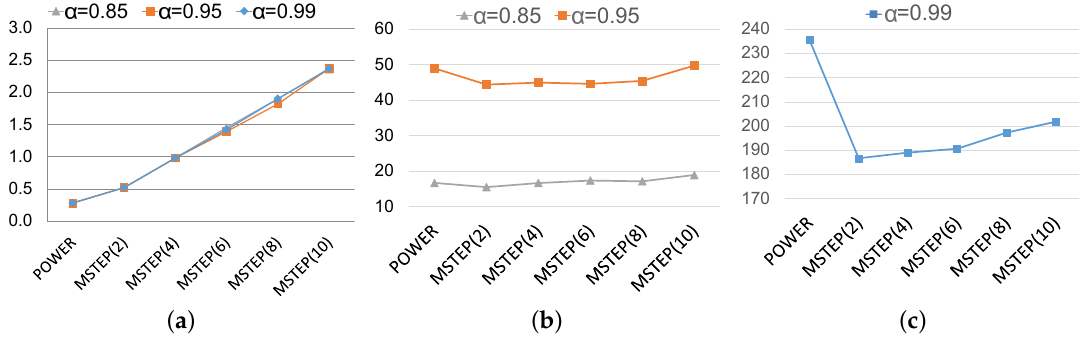
Figure 3. Parallel MSTEP algorithms, uk-2002, SM p = 4 ( 1 × 4 ) , (cid:101) = 10 − 6 . ( a ) Time per iteration (s.). ( b ) Total time (s.). ( c ) Total time (s.).